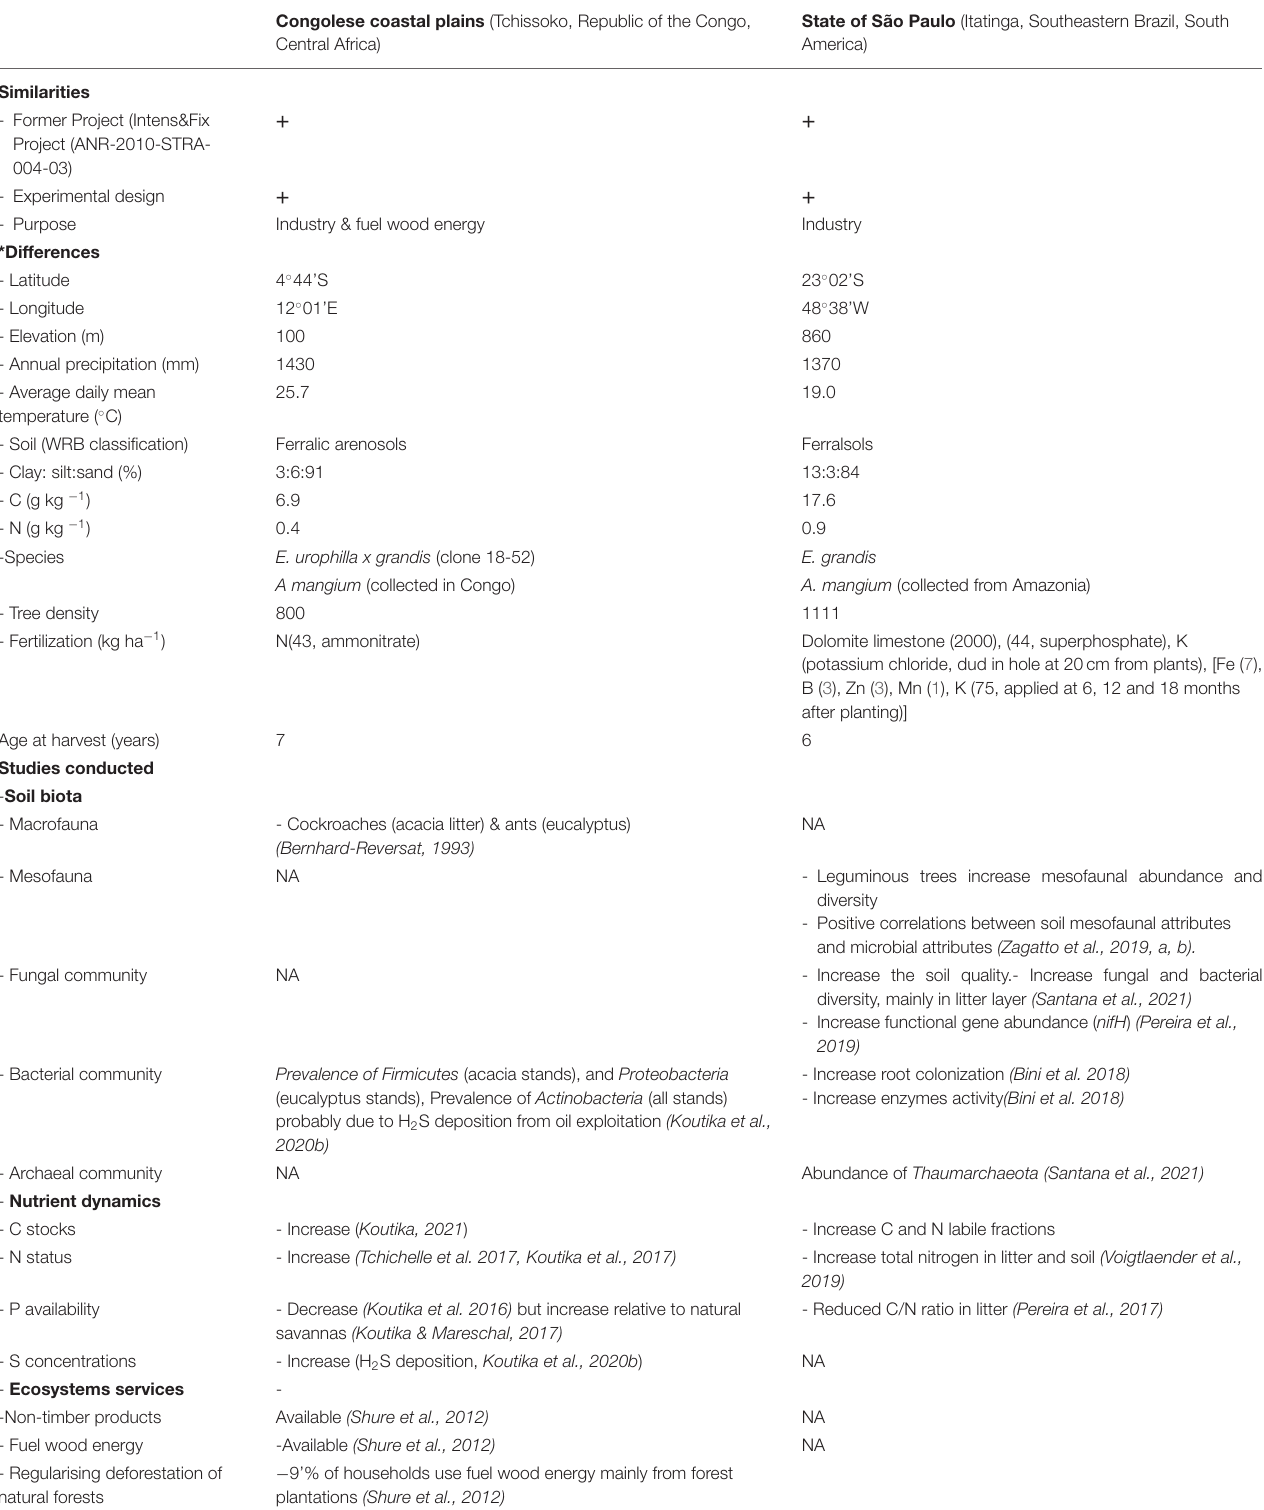
TABLE 1 | Main characteristics of the two locations of the selected case